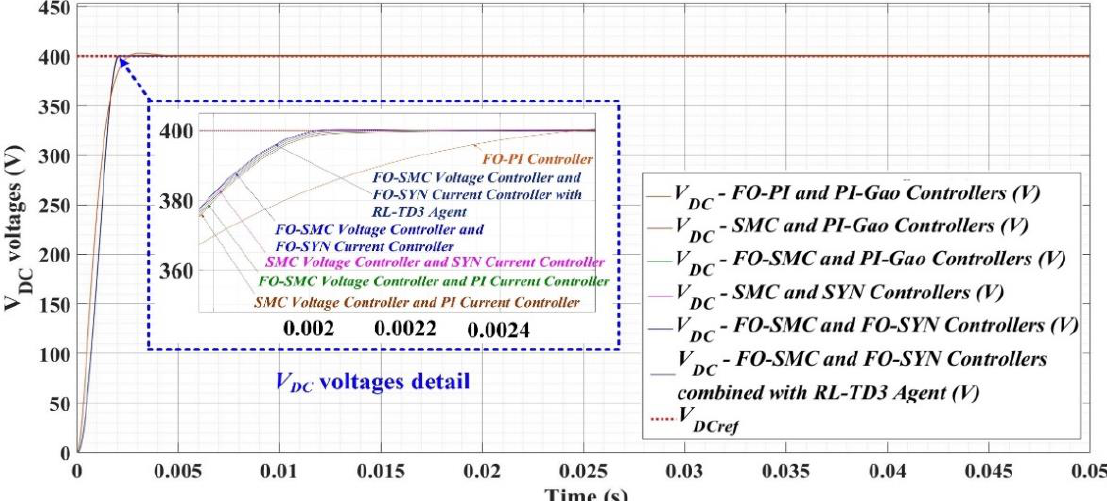
Figure 18. V DC voltage time evolution from the comparison of the FO PI and PI-Gao controllers, SMC and PI-Gao controllers, FO SMC and PI-Gao controllers, SMC and synergetic controllers, FO SMC and FO synergetic controllers, and FO SMC and FO synergetic controllers combined with the RL-TD3 agent for the control system of the power electronic converter.